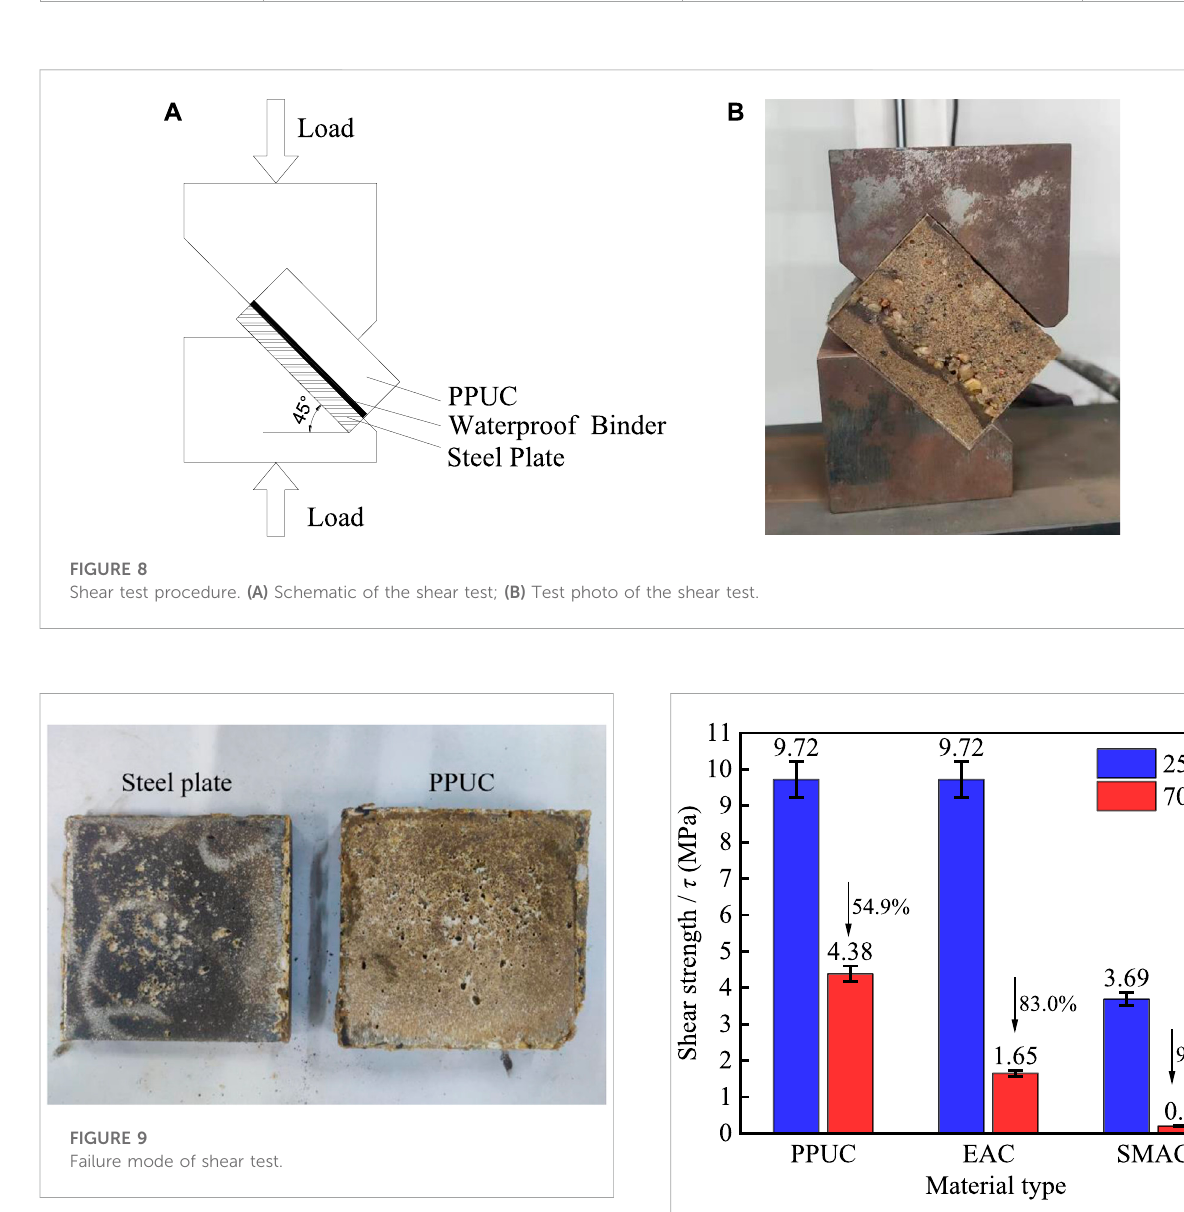
FIGURE 10 Shear test